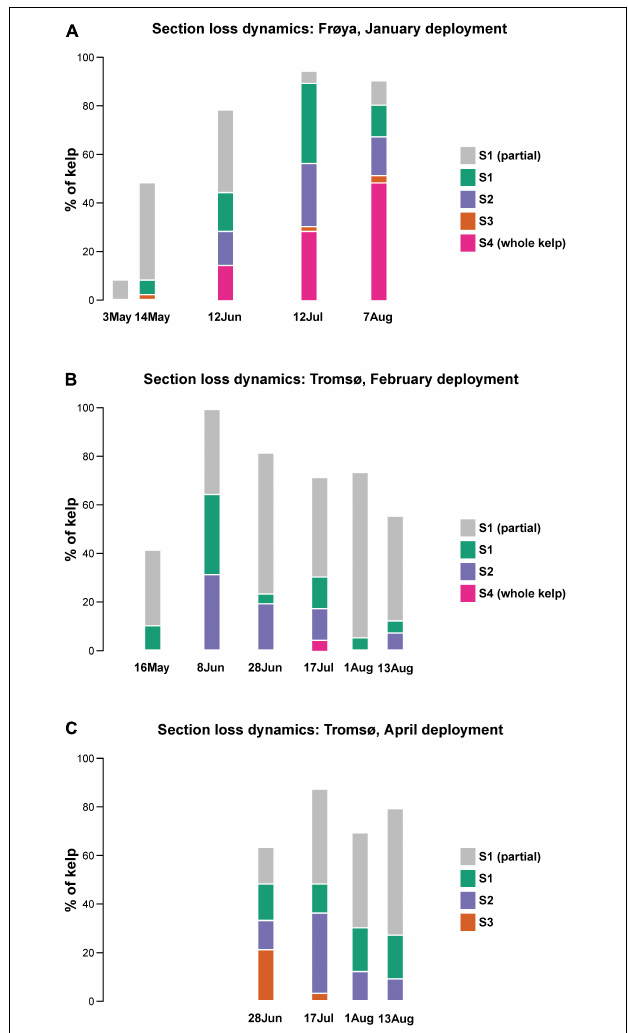
FIGURE 7 | Loss of sections in (A) Frøya, (B) Tromsø, February deployment, and (C) Tromsø, April deployment.